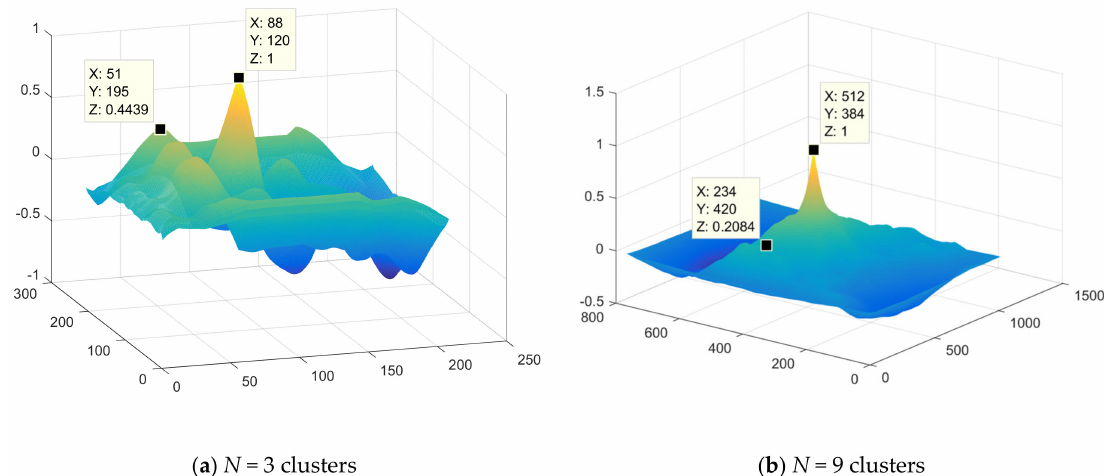
Figure 9. Plot of two-dimensional correlation function.